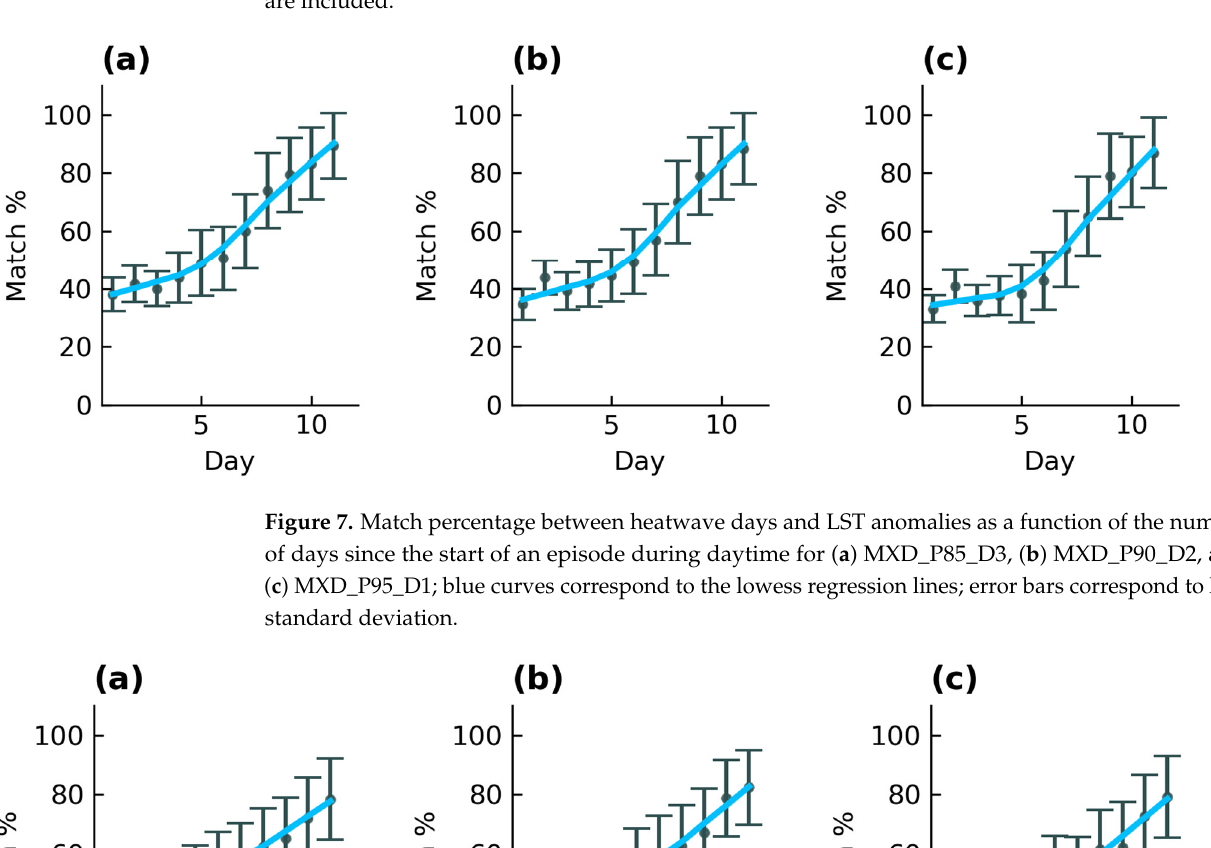
Figure 6. Match percentage between heatwave days and LST anomalies (MXD_P85_D3) per land cover type for ( a ) daytime and ( b ) nighttime. Only land cover types with at least 5% coverage are included.